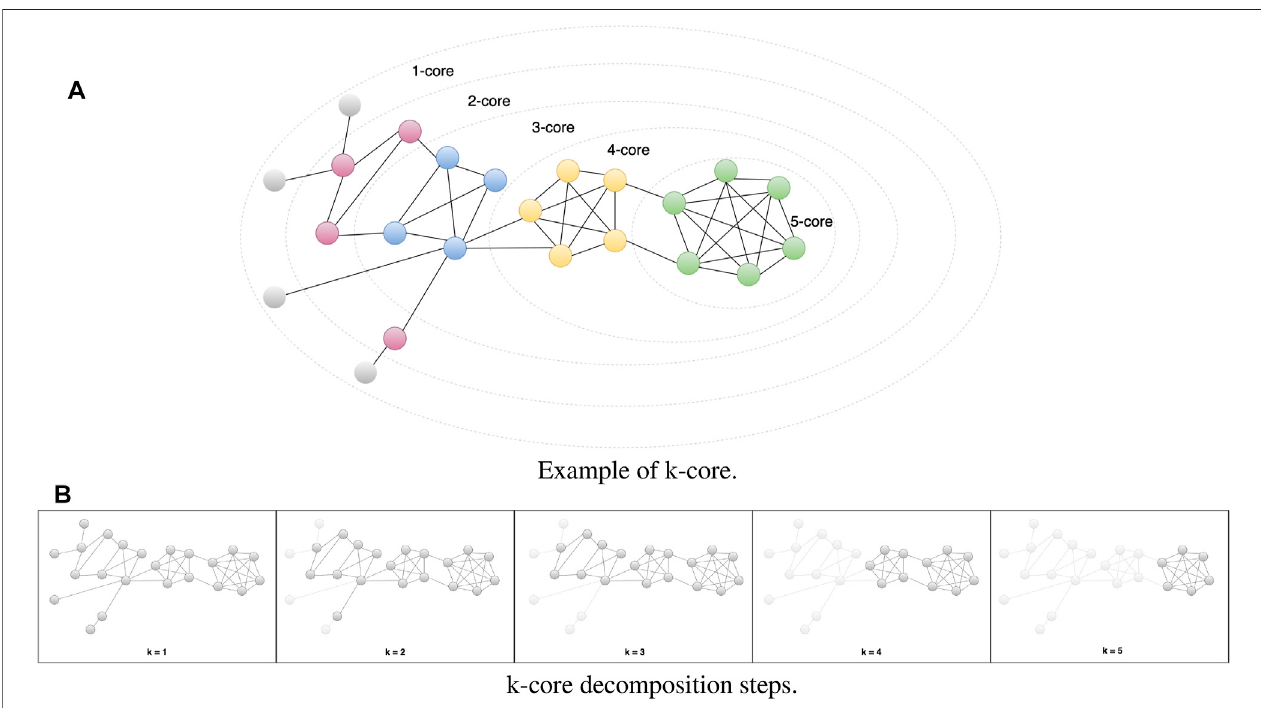
FIGURE 5 | An example of the structure of k-cores in a network. The nodes are arranged in a series of concentric cores (A) , each corresponding to a particular k - core.Thecolorofthenodescorrespondstotheircorenessvalue k :k=1asgrey;k=2aspurple;k=3asblue;k=4asyellow;k=5asgreen.Thepanelin (B) showsan example of k-core decomposition via recursive removal of nodes to get the main